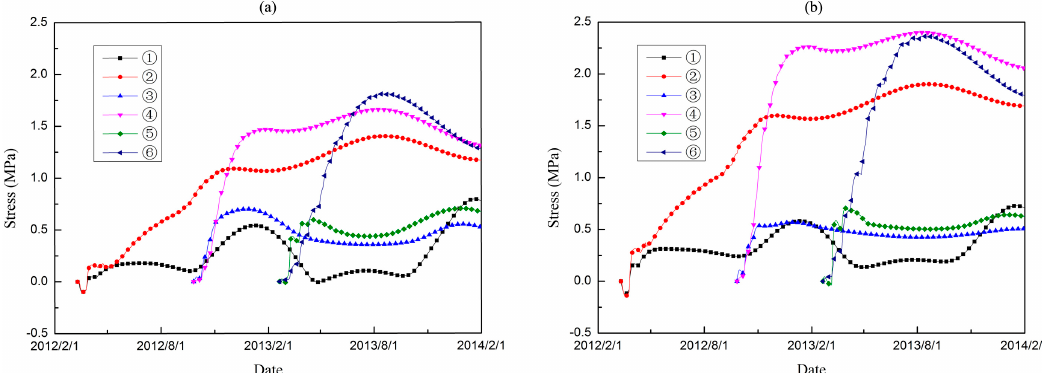
Figure 17. The max principle stress histories of different typical points. ( a ) thermo-chemical-mechanical coupled model; ( b ) conventional model.